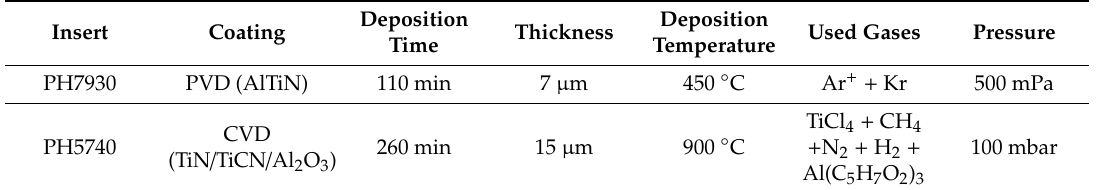
Table 2. Main data about the coatings’ deposition processes. PVD: physical vapor deposition; CVD: chemical vapor